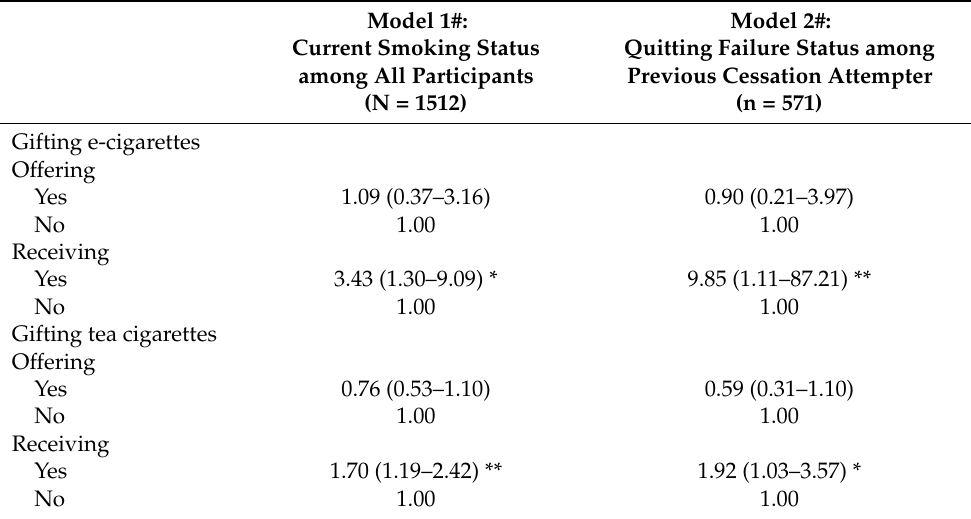
Table 3. Logistic regression analysis for smoking and quitting situation with gifting e-cigarettes and tea